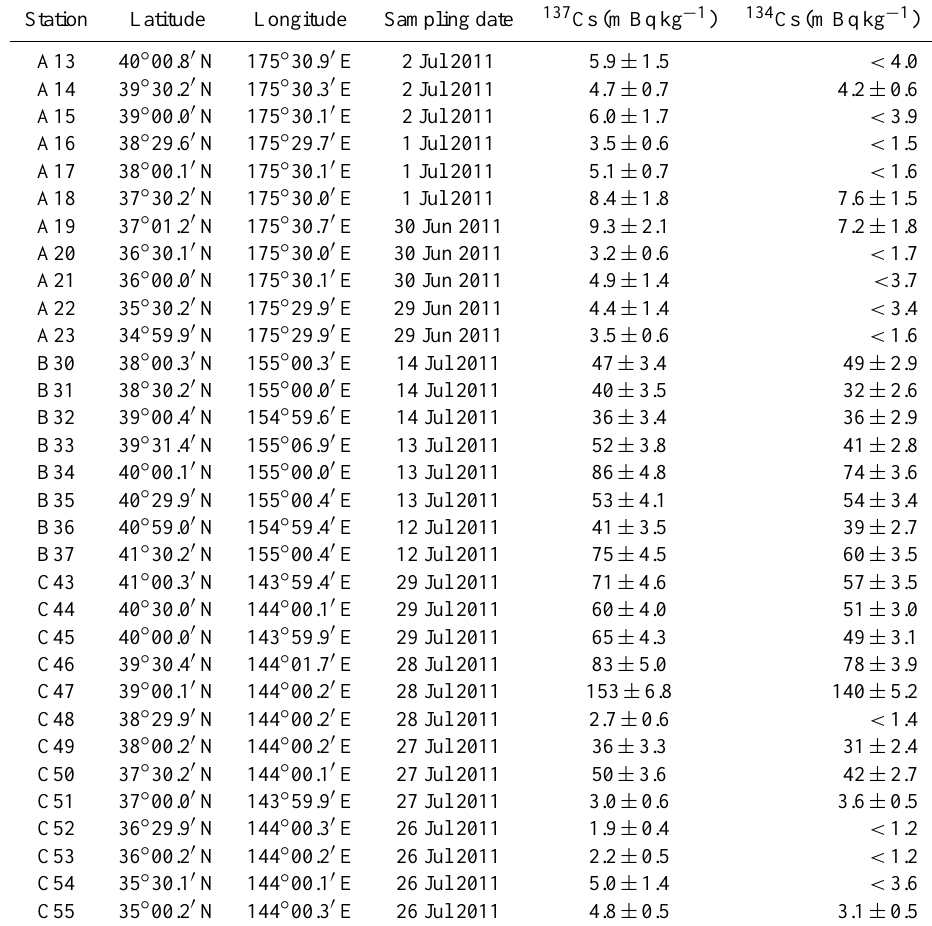
Table 1. Concentrations of 134 Cs and 137 Cs in the surface seawater collected during 30 June and 29 July 2011. Station